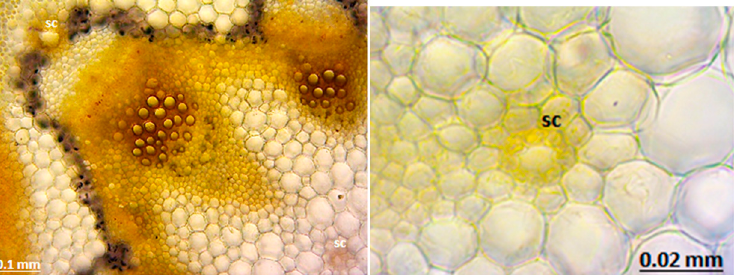
Figure 5. Secretory canals at the peduncle of Zosima absinthifolia by light microscopy. Molecules 2019 , 24 , x FOR PEER REVIEW